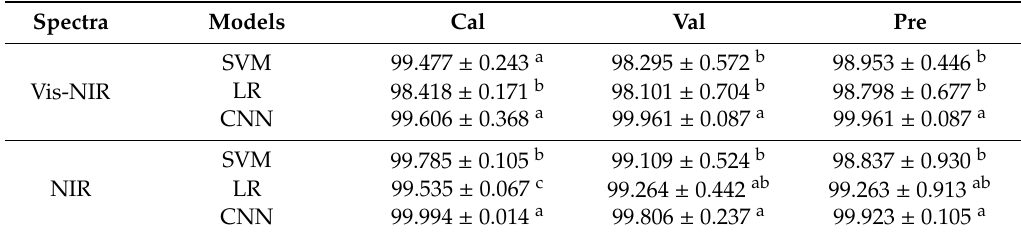
Table 1. The results of the classification models based on full wavelengths.